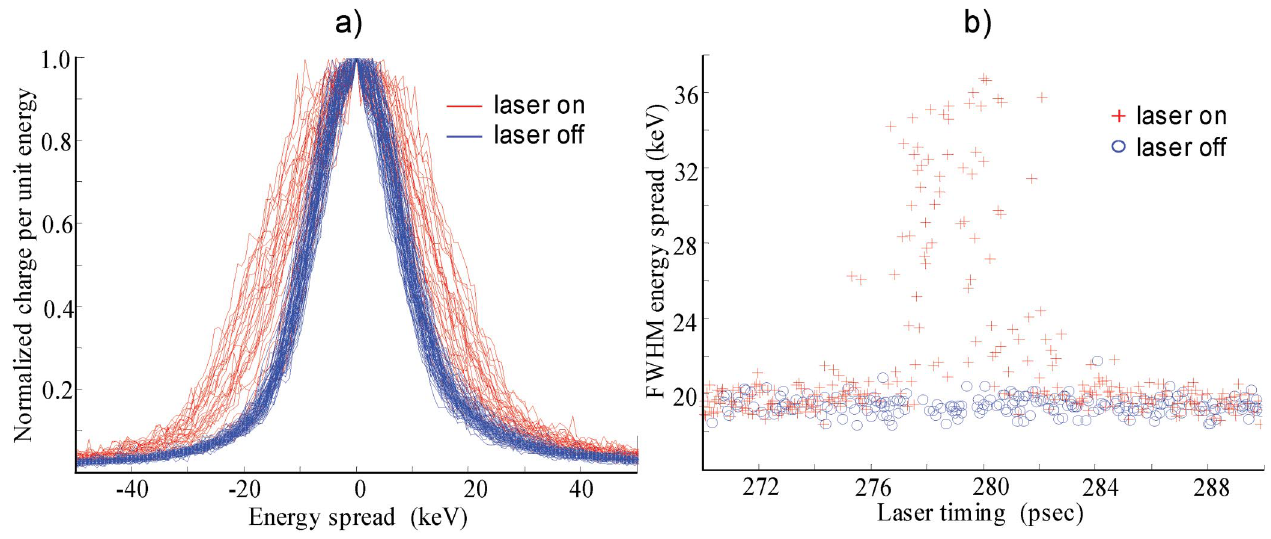
FIG. 8. (Color) (a) Experimentally observed laser-driven energy modulation near the condition of optimum temporal overlap. (b) Laser time scan showing the FWHM energy spread of the electron